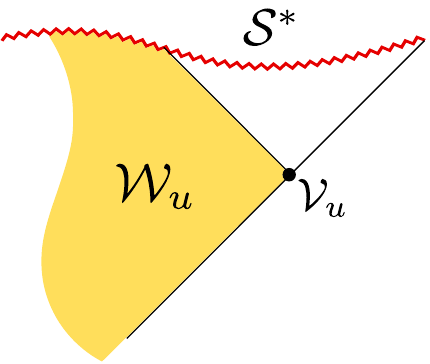
Figure 1 . The WdW patch W u (in yellow), parametrized by a null coordinate on the boundary of the singularity’s past domain of dependence. Entropy is measured by the volume of V u and complexity is measured by the action of W u . This construction is modi(cid:12)ed in the obvious manner under time